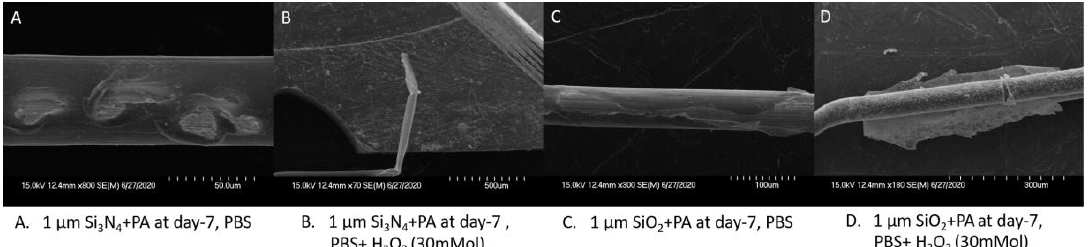
+ PBS and PBS solutions. 2 O 2